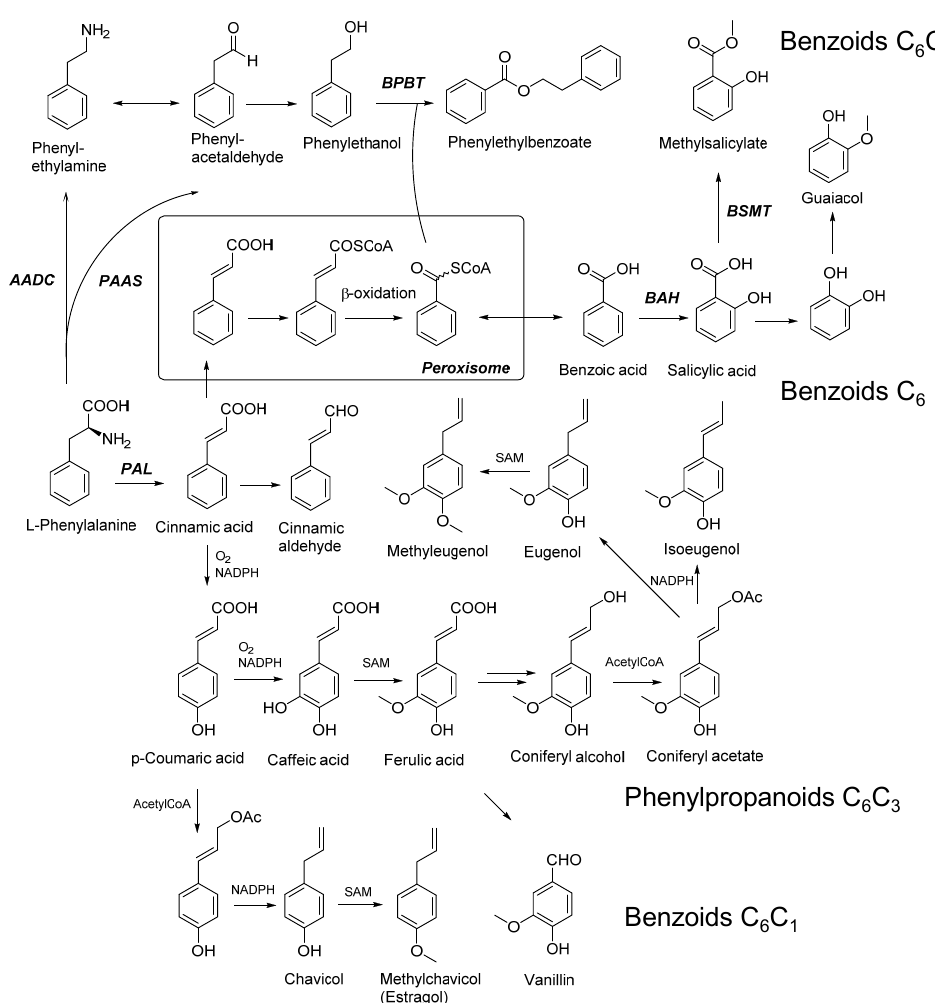
Figure 2. Metabolic pathways in plants that lead to the formation of volatile benzoids and phenylpropanoids from phenylalanine [31]. AADC: aromatic amino acid decarboxylase; BAH: benzoic acid 2-hydroxlase; BPB: benzoylCoA:benzylalcohol / 2-phenylethanol benzoyltransferase; BSMT: benzoic acid / salicylic acid carboxyl methyltransferase; CoA: coenzyme A; NADPH: nicotinamide adenine dinucleotide phosphate (reduced form); PAAS: phenylacetaldehyd synthase; PAL: phenylalanine ammonia lyase; SAM: S-adenosyl